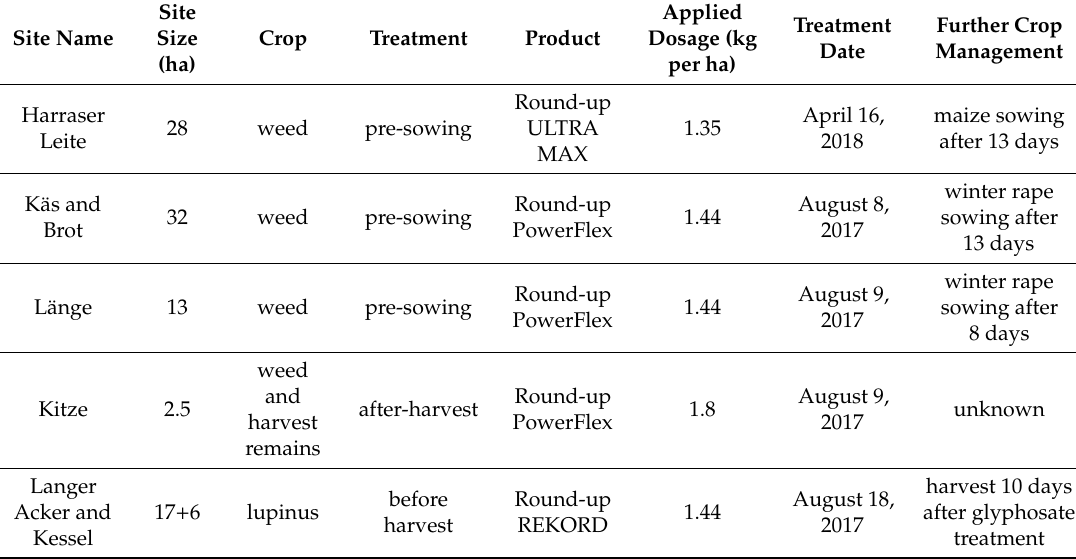
Table 1. Overview of agricultural test sites and scenario characteristics due to herbicide treatment and